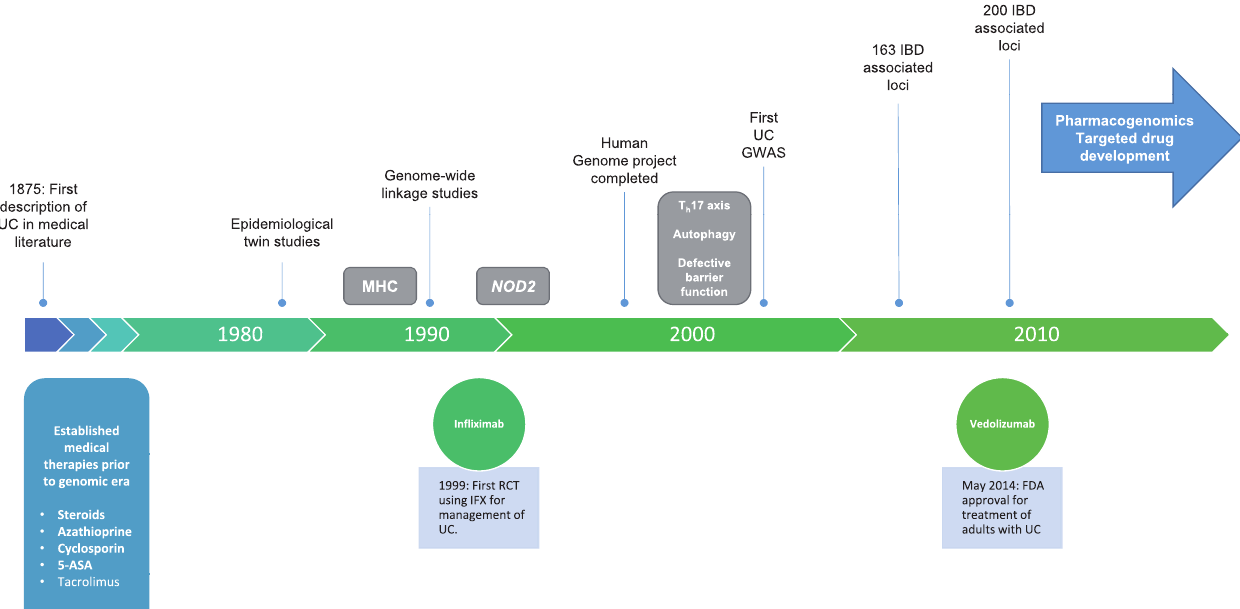
Figure 1. Timeline of genetic discoveries and recent drug developments in IBD. Adapted from Expert Rev Gastroenterol Hepatol. 2009